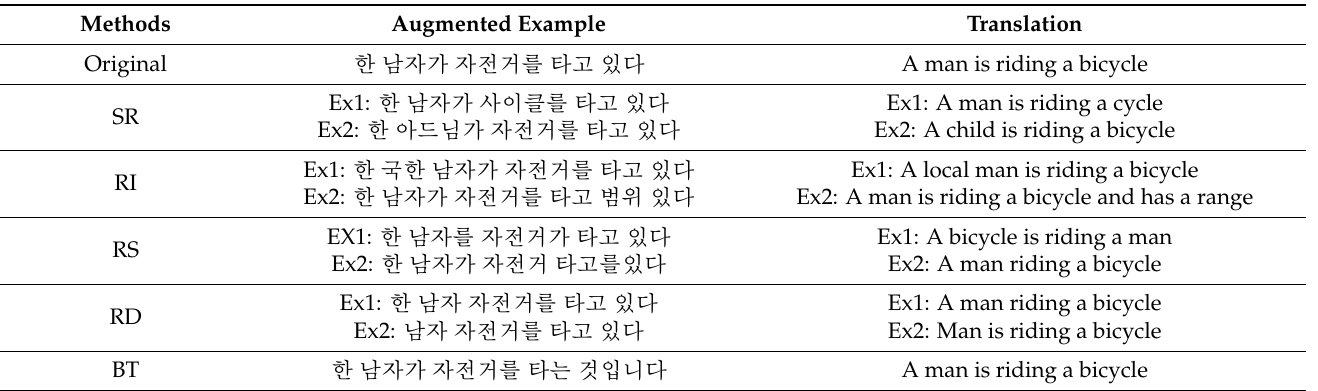
Table 2. Examples of text data augmentation.